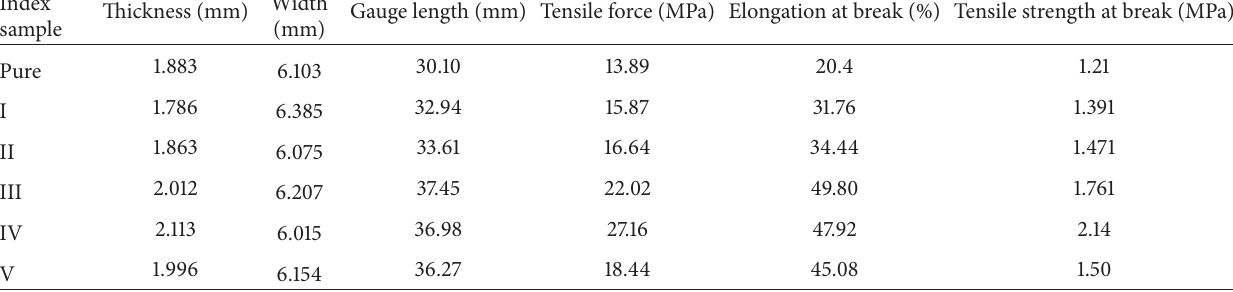
Table 1: Tensile strength and elongation at failure of OMMT/PU.